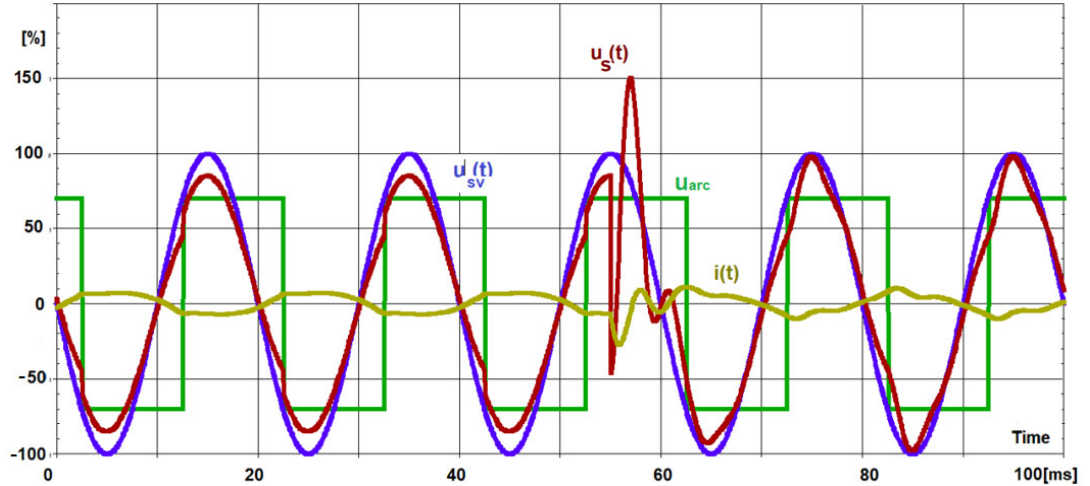
Figure 25. Oscillograms of the supply (source) voltage U SV ( t ), the arc furnace supply voltage U S ( t ),